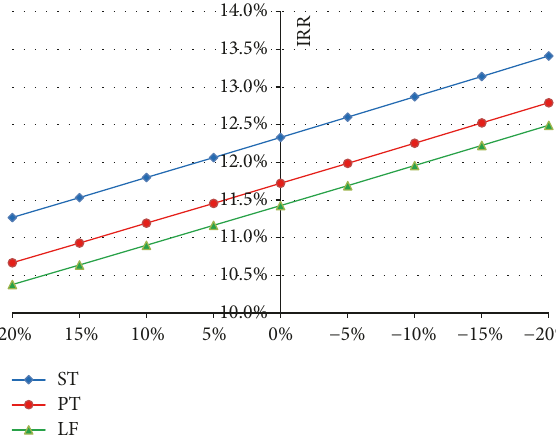
Figure 3: The sensitivity analysis results of the IRR of CSP to the operation and maintenance